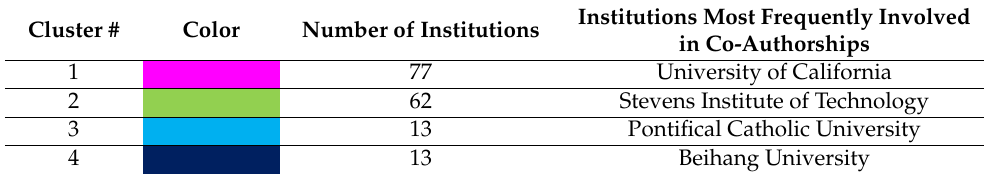
Table 11. Clusters of institutions involved in co-authorships. Cluster # Color